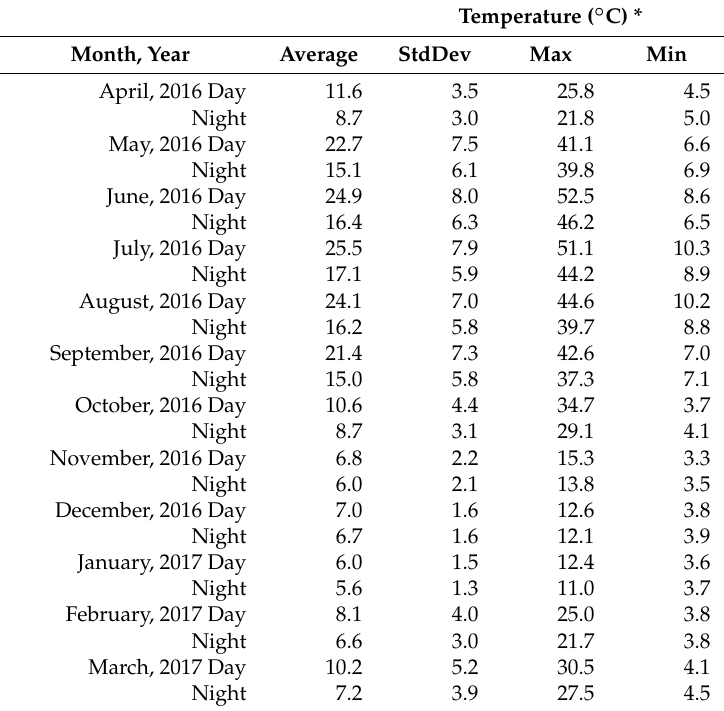
Table A1. Monthly average, standard deviation, minimum and maximum temperature fluctuation patterns for day and night from April 2016–March 2017 in the greenhouse where the second and third inoculation trials took